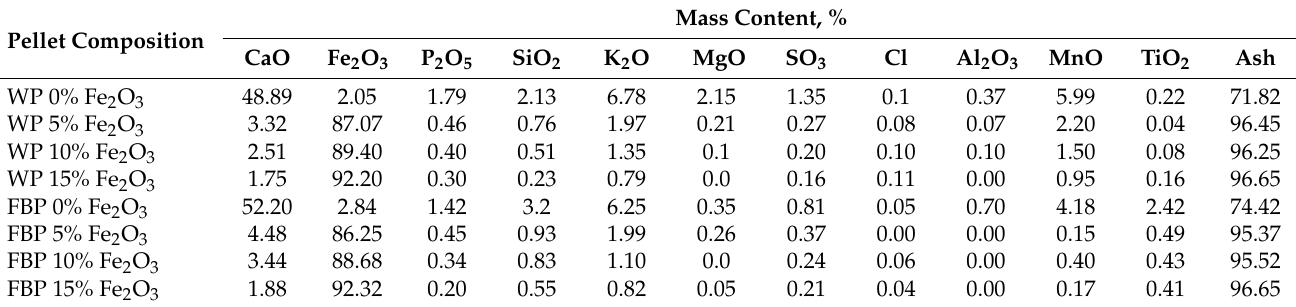
Table 9. Contents of individual chemical compounds in residues from the combustion of wood pellets and furniture board pellets, depending on the proportion of the catalyst in the